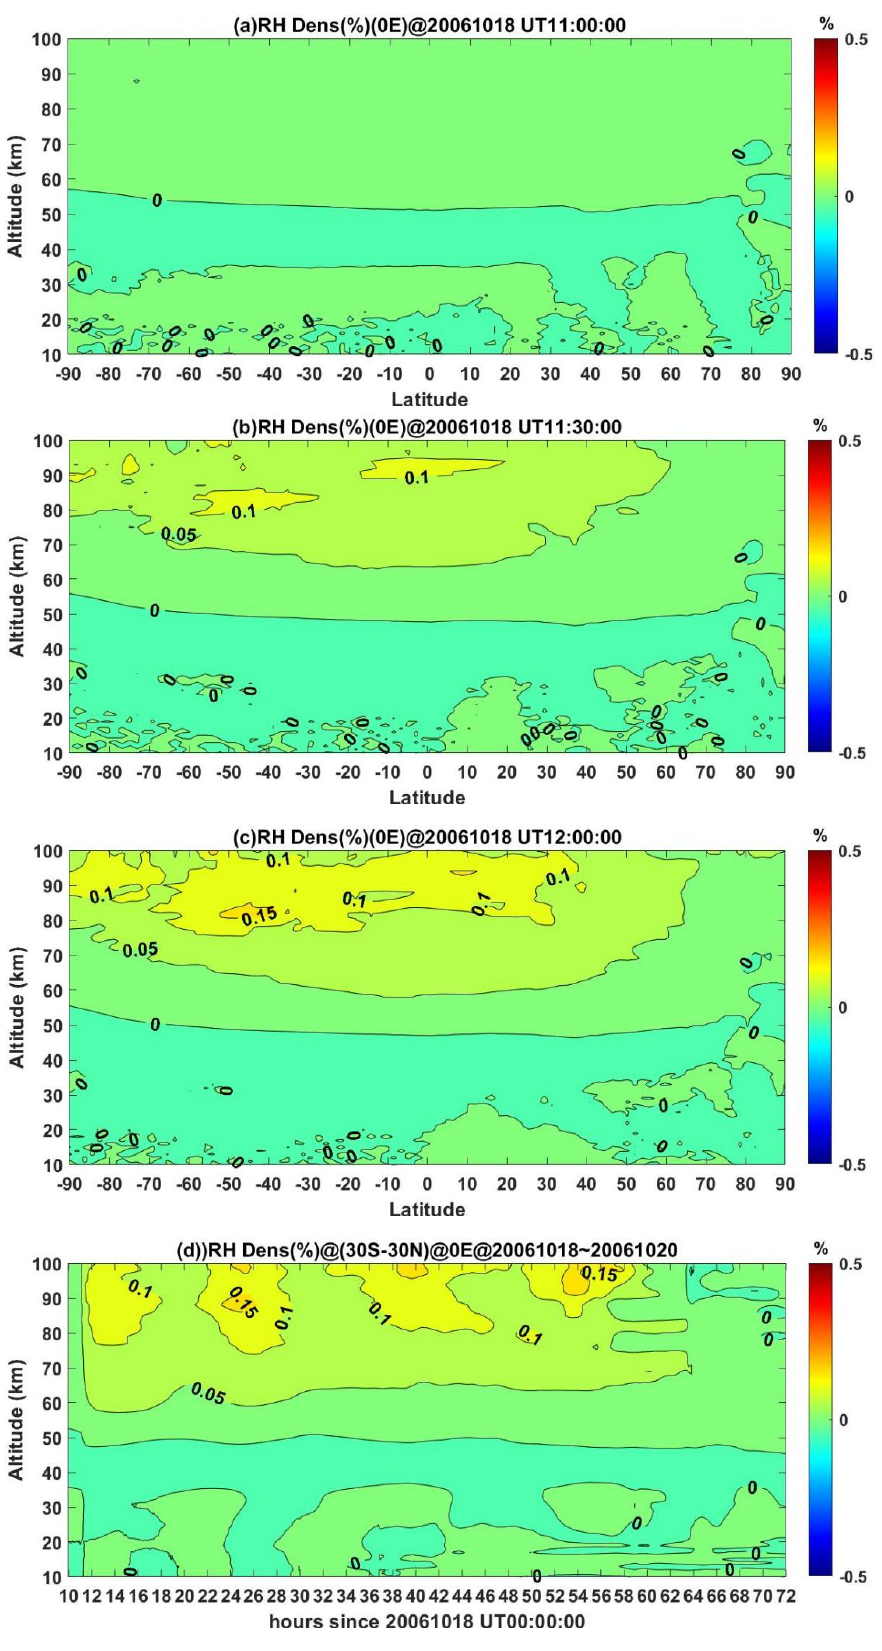
Figure 6. Differences in the atmospheric density between the flare simulation and baseline simula- tion. (( a − d ); flare simulation minus baseline simulation). (( a – d ); flare simulation minus baseline